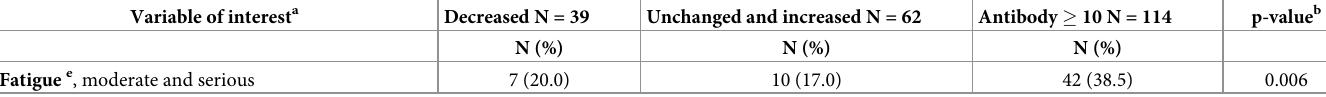
a Table 3 includes 212 PCR+ participants and three PCR- participants with detectable antibodies. b P-value for comparison between decreased and the group (unchanged, increased, and antibody � 10). c